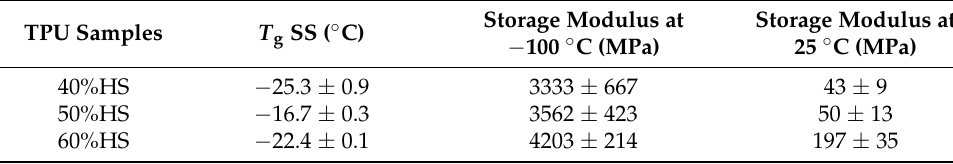
Figure 3. Dynamic mechanical analysis of solid TPUs with different HS%. Table 4. DMTA data of solid TPUs with different HS